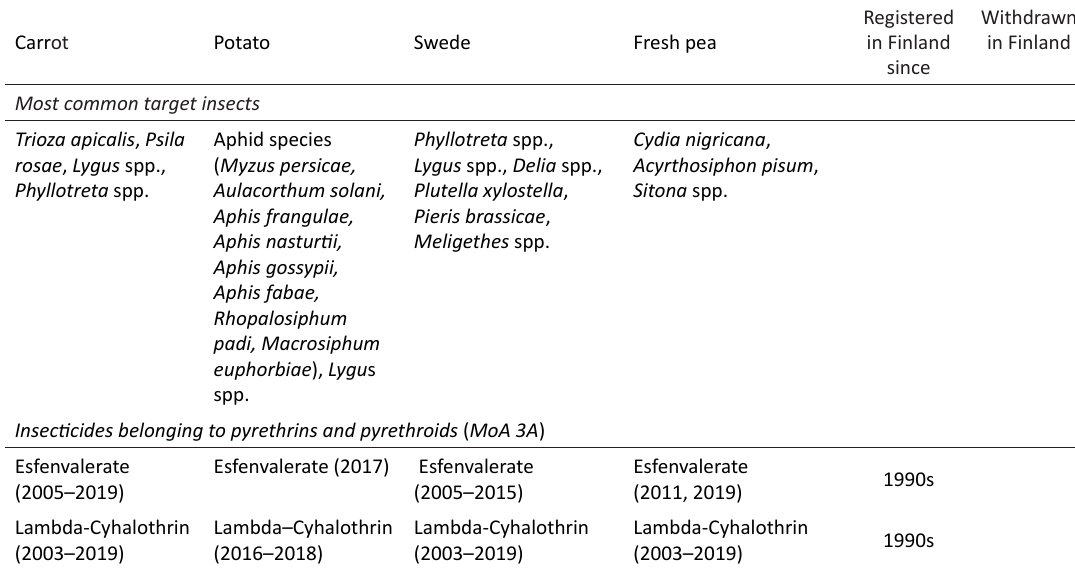
Table 3. The most common insect pests (Natural Resources Institute Finland 2021c) and the insecticides used for their control in studied crops (the database of Apetit Ruoka Ltd.), the year of registration and withdrawal from the Finnish market, and derogations of non-registered PPPs (Finnish Safety and Chemicals Agency